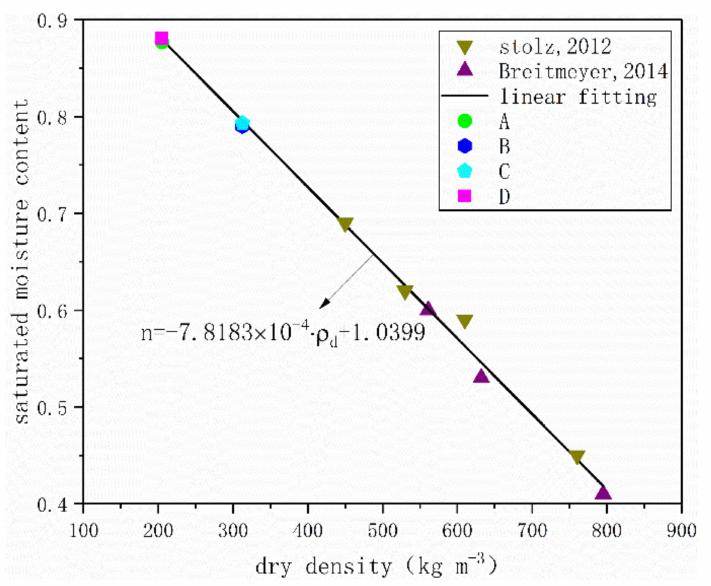
Figure 2. Relationship between saturated moisture content and dry density of